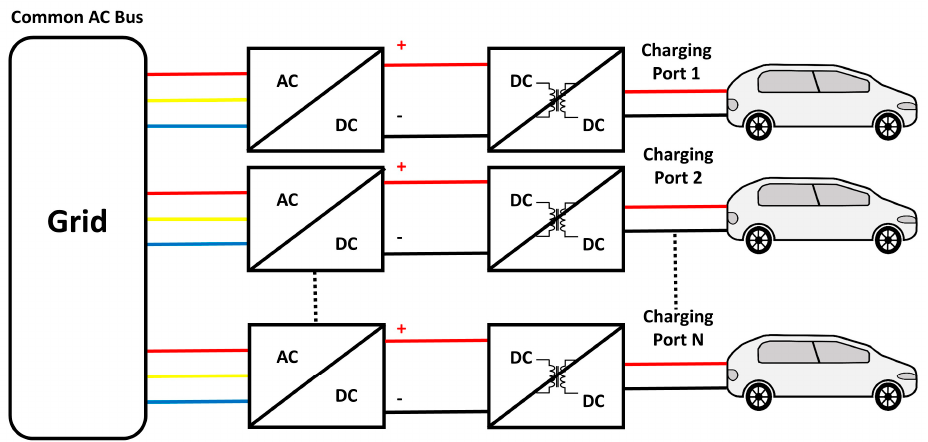
Figure 5. The charging station of BEVs and PHEVs with common AC bus architecture [6].